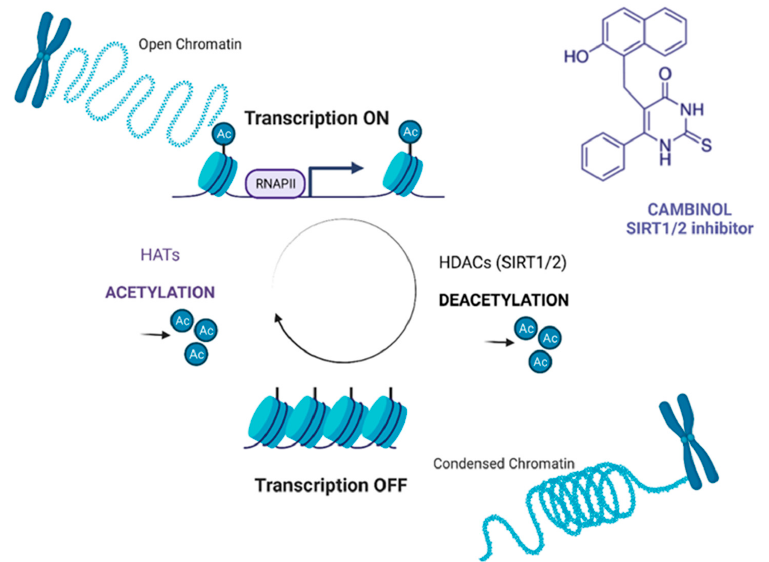
Figure 1. The mechanism of CAM action. CAM (SIRT 1/2 inhibitor) inhibits the activity of SIRT 1 and 2 (HDACs), which leads to the relaxation of chromatin and activation of transcription.